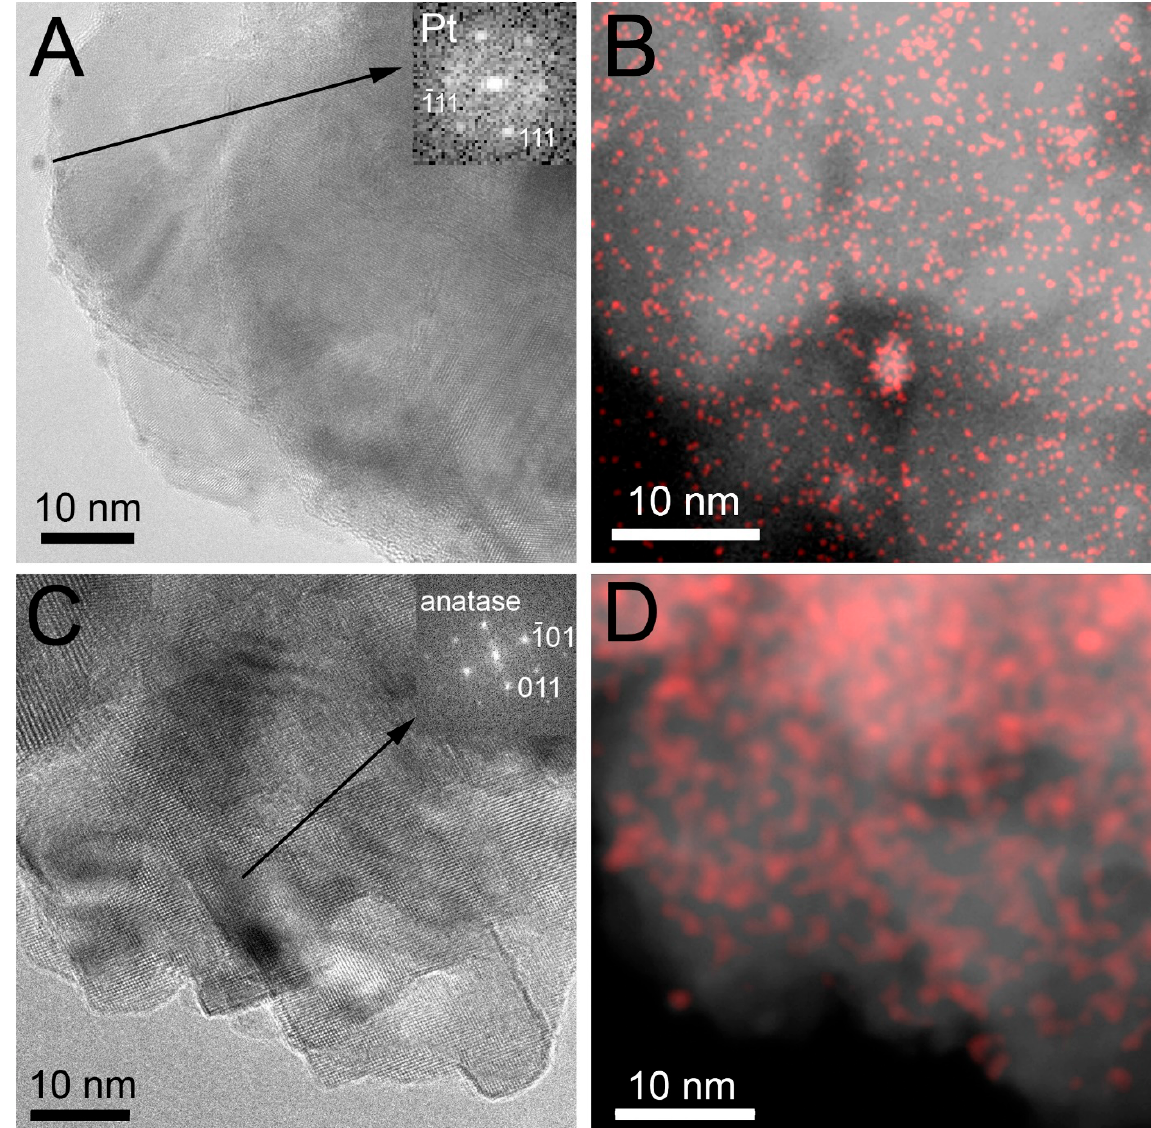
Figure 5. High-resolution scanning TEM (STEM) images and element maps of selected samples. ( A ) STEM image of sample SG500PtH2red. FFT (insert) shows <111> Pt reflections; ( B ) Pt element map of sample SG500PtH2red; ( C ) STEM image of sample SG500PtCalc. FFT (insert) shows <011> anatase reflections; ( D) Pt element map of SG500PtCalc.